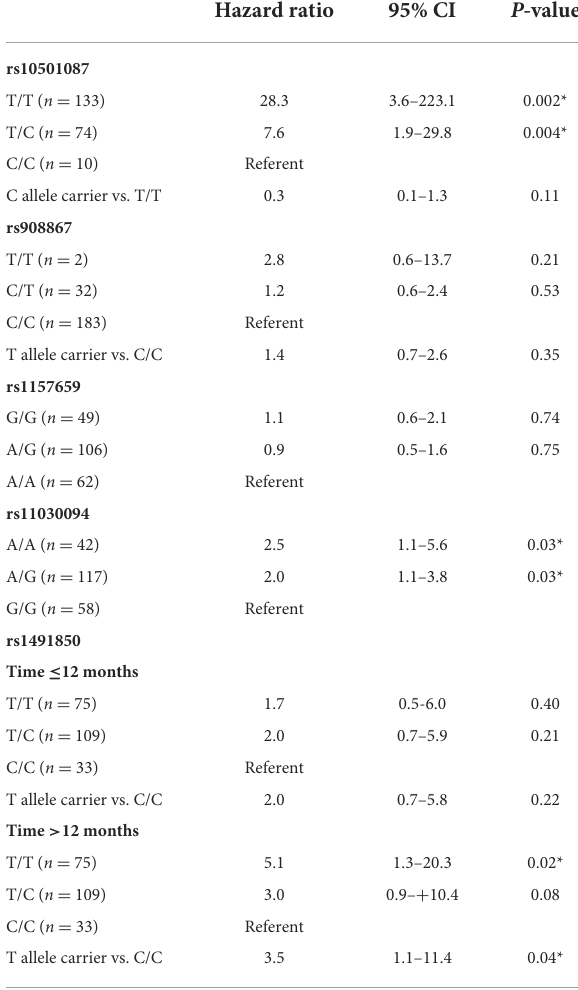
TABLE 1 Survival analysis for time to needing dopaminergic therapy for placebo and α -tocopherol treated DATATOP subset with DNA by BDNF